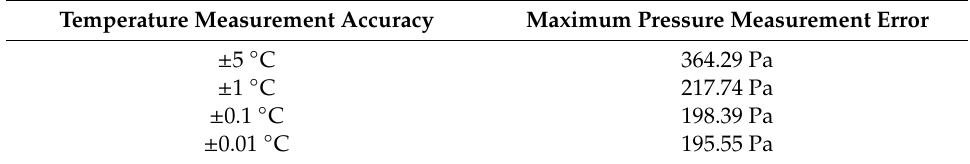
Table 2. Error fitting results with di ff erent temperature measurement